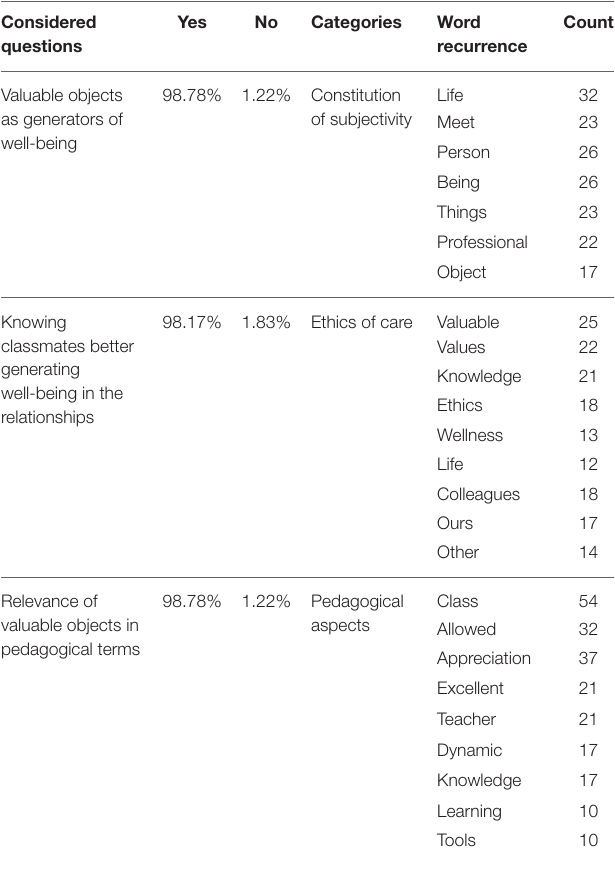
TABLE 1 | Rapid reconnaissance survey—recurrence of words during courses. Considered